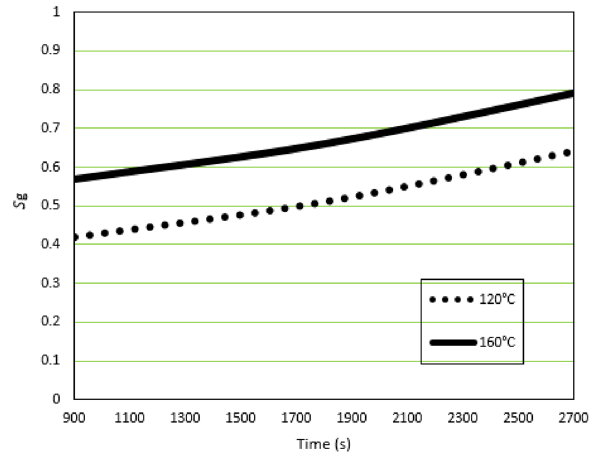
Fig. 4 Gas saturation variation for increasing time